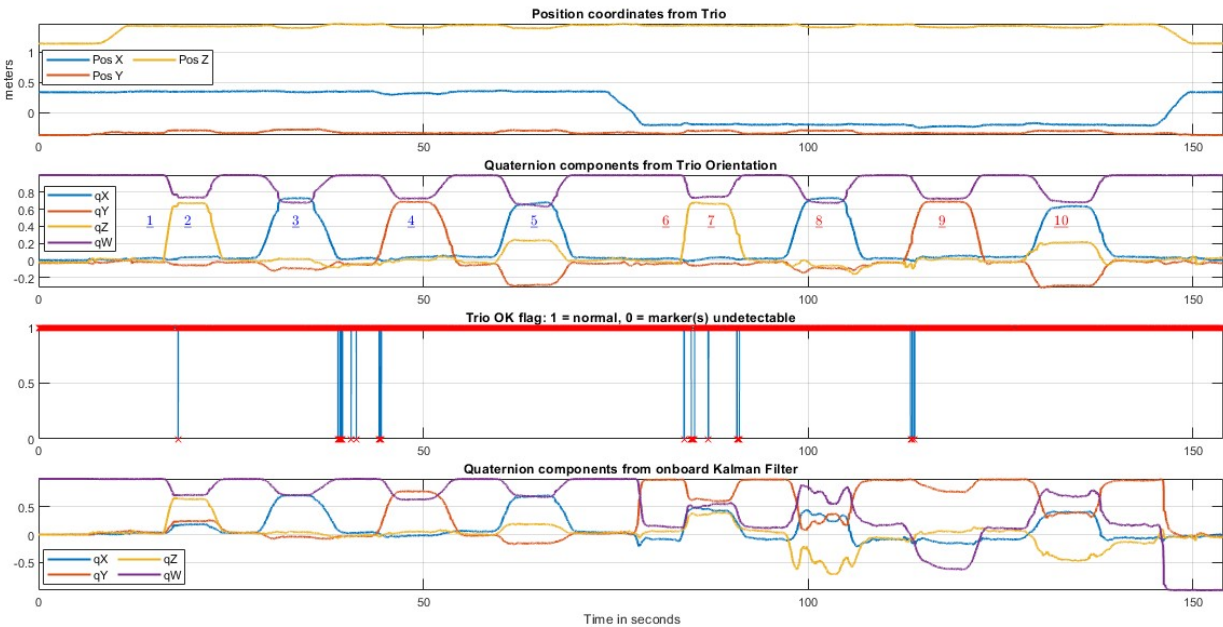
Figure 4. From top to bottom: plot of the three position coordinates with respect to the origin of the Trio frame (TX, TY, TZ); temporal evolution of the four components of the rigid body orientation estimate from the Trio system as a quaternion (converted to the MARGs left-hand frame); plot of the isTracked flag through the recording; and temporal evolution of the four components of onboard Kalman filter quaternion orientation estimate. (Underlined numbers indicate the poses).